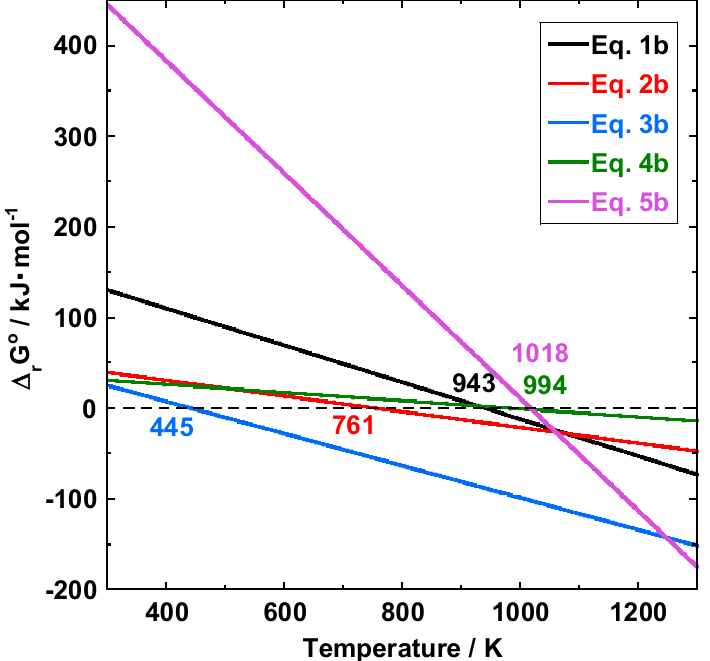
Figure 6. Temperature dependence of Δ r G°.